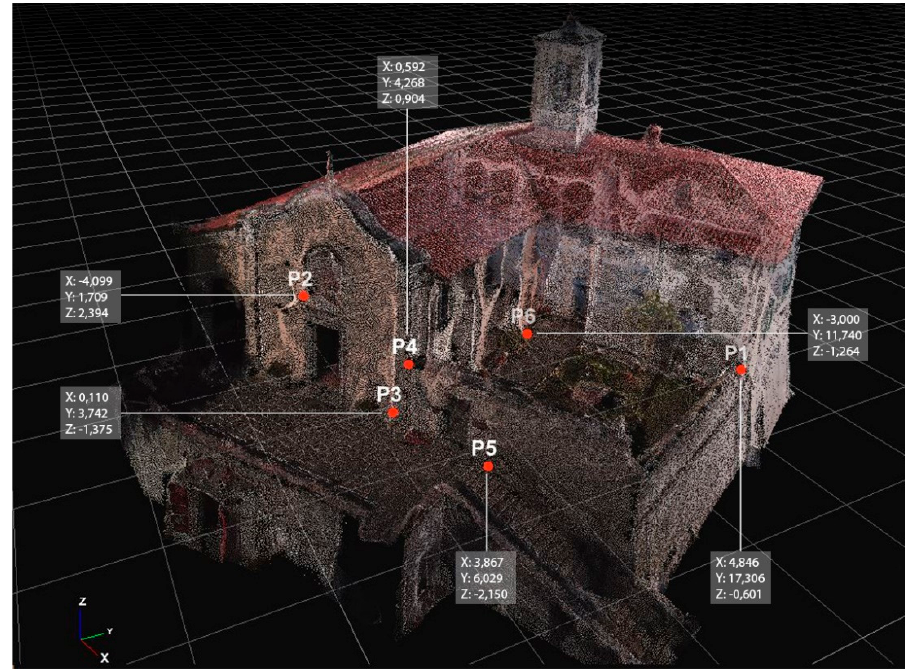
Figure 7. GCPs used for the aerial photogrammetric absolute orientation.